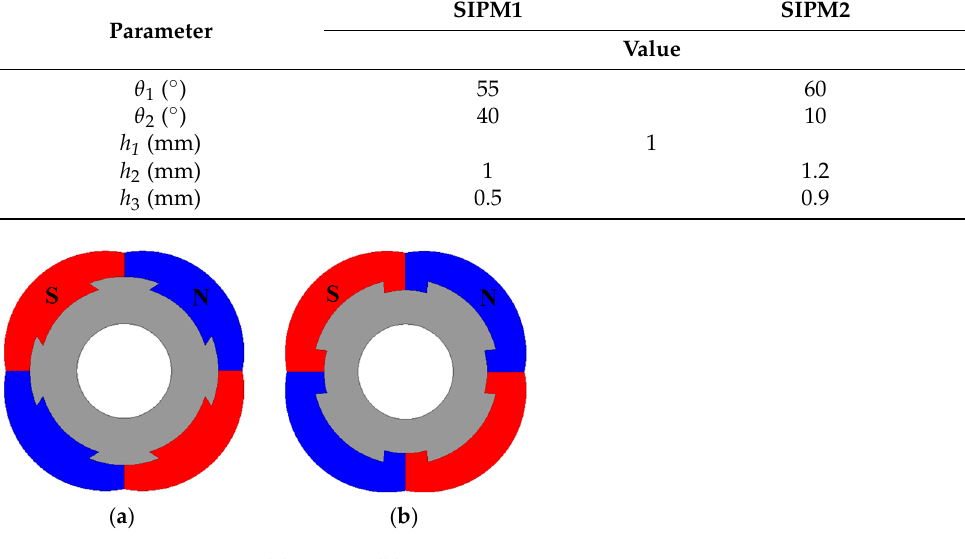
Figure 6. Rotor structures. ( a ) SIPM1. ( b ) SIPM2.